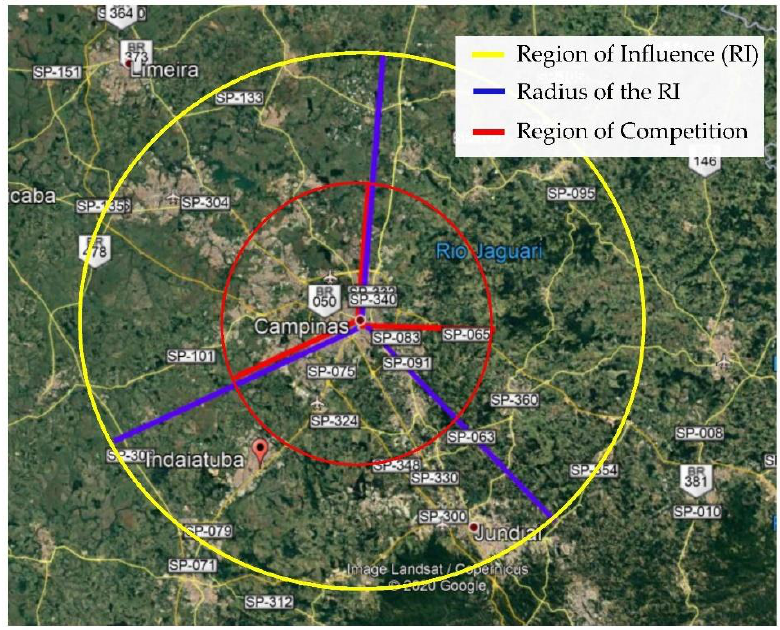
Figure 13. Region of influence and region of competition.